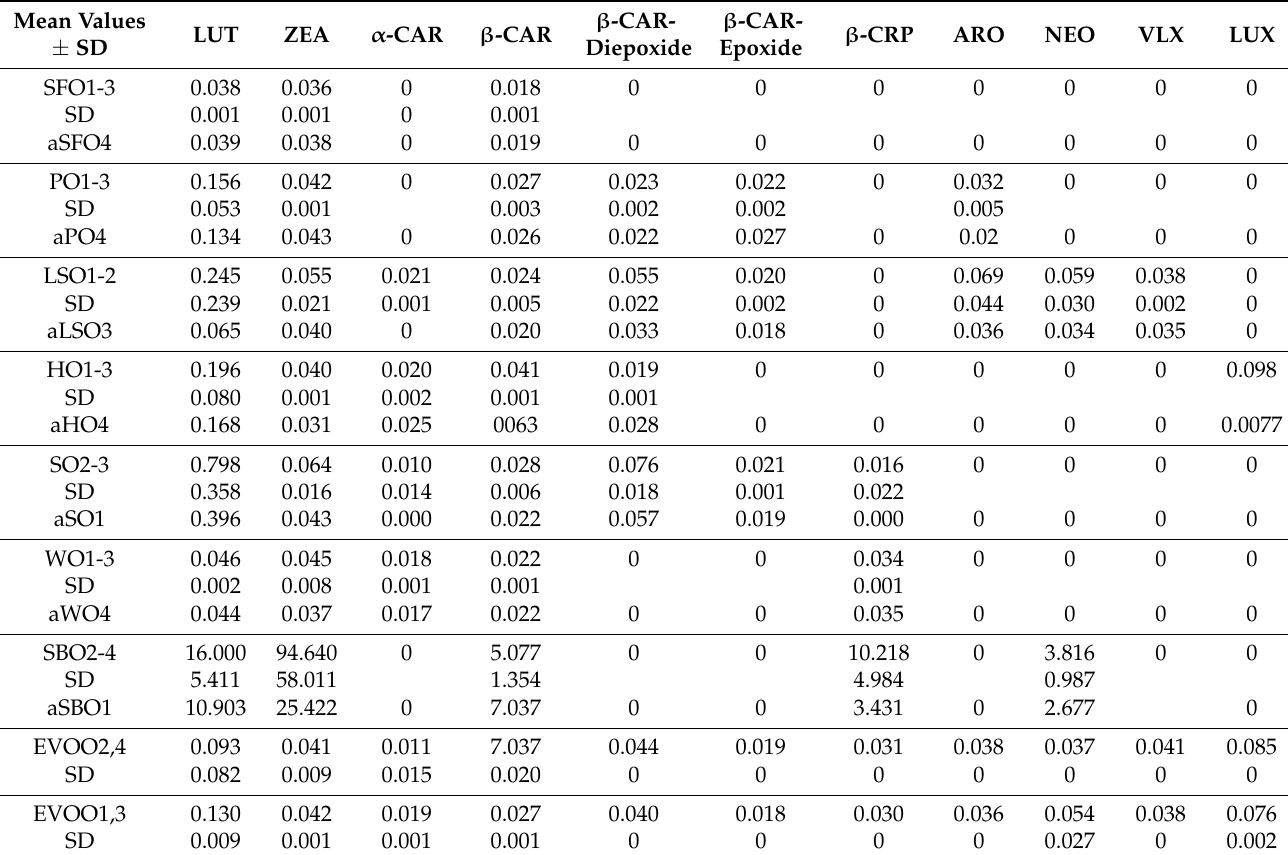
Table 3. Mean values (mg/100 g) of individual carotenoids separated and identified in commercial and authentic oils, respectively. For oil abbreviations, see Table